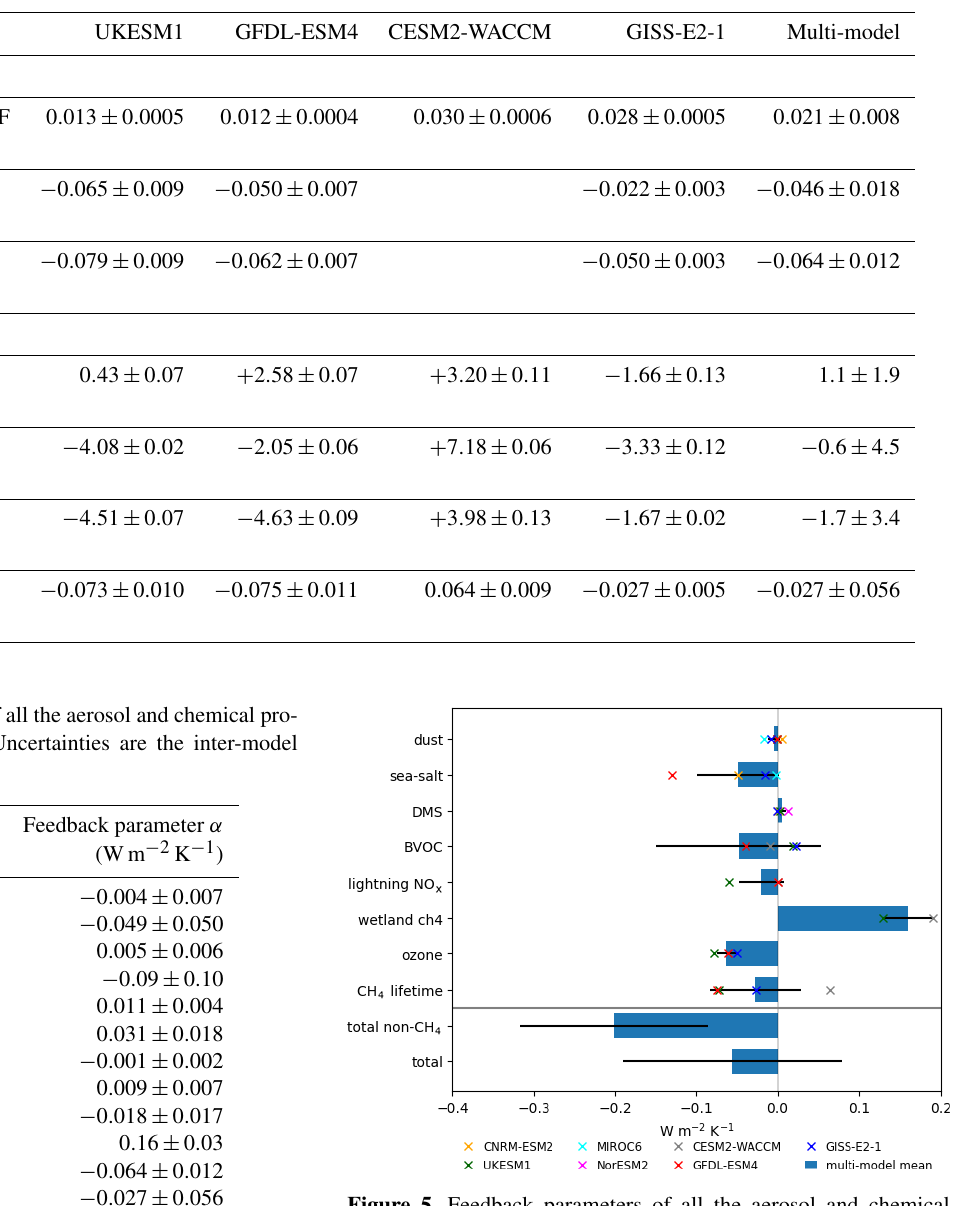
Table 14. Comparison of expected changes in ozone SARF and methane lifetime with that diagnosed from 4xCO2 . The residual is given by the difference and is converted to a feedback using radiative efficiencies for methane lifetime.